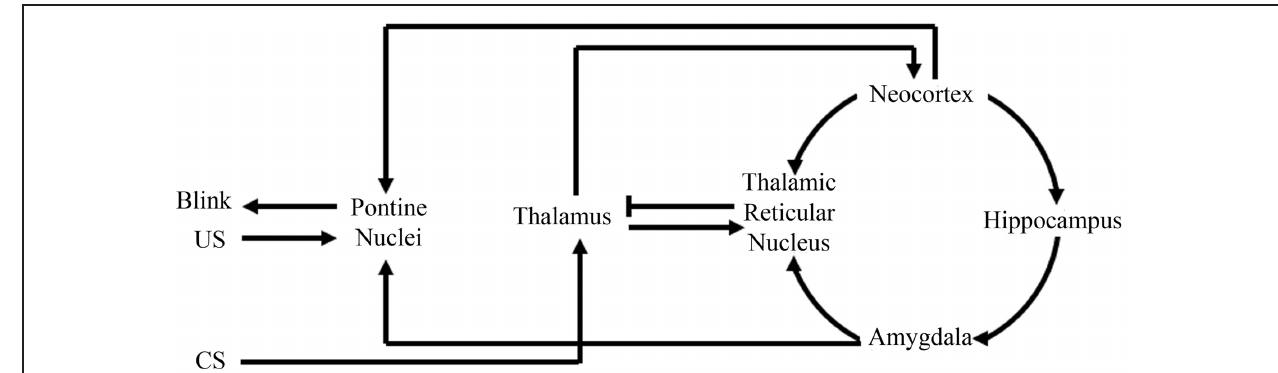
neocortex receives. Modulation of neocortical input would modulate neocortical activation of the pontine nuclei that directly assists in generating the appropriate conditioned response “Blink.” Note in the above illustration, the amygdala can facilitate appropriate behavioral responses by not only modulating neocortical activation of the pontine nuclei via thalamic reticular nuclear stimulation, but also via direct projections to the pontine